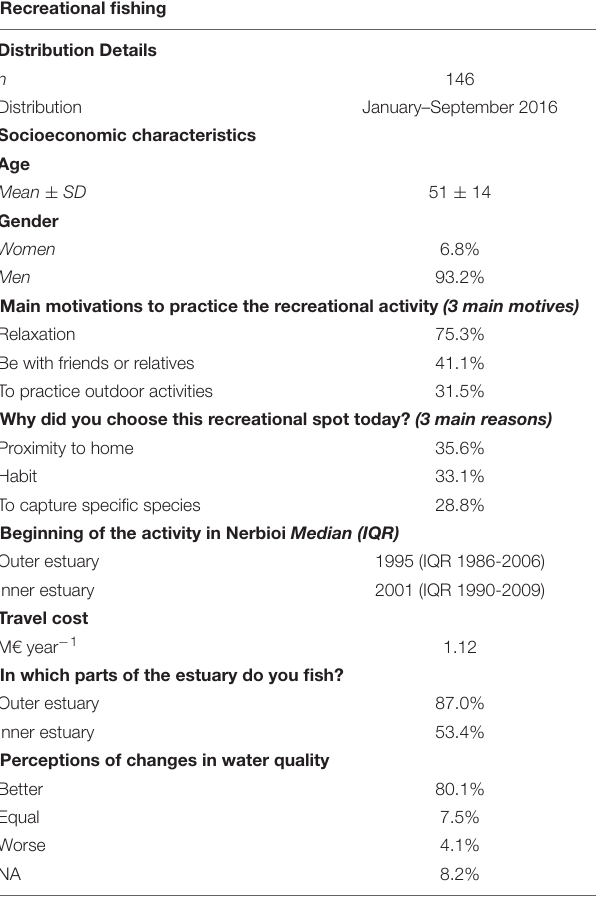
TABLE 3 | Summary of the main characteristics and results of the questionnaires distributed among recreational fishers in the Nerbioi estuary. Recreational fishing